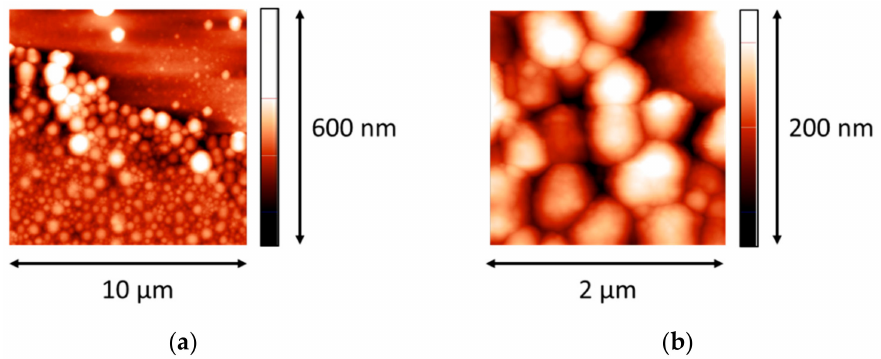
Figure 1. AFM images of a LYS microgel dispersion without purification. ( a , b ) images correspond to different magnifications.